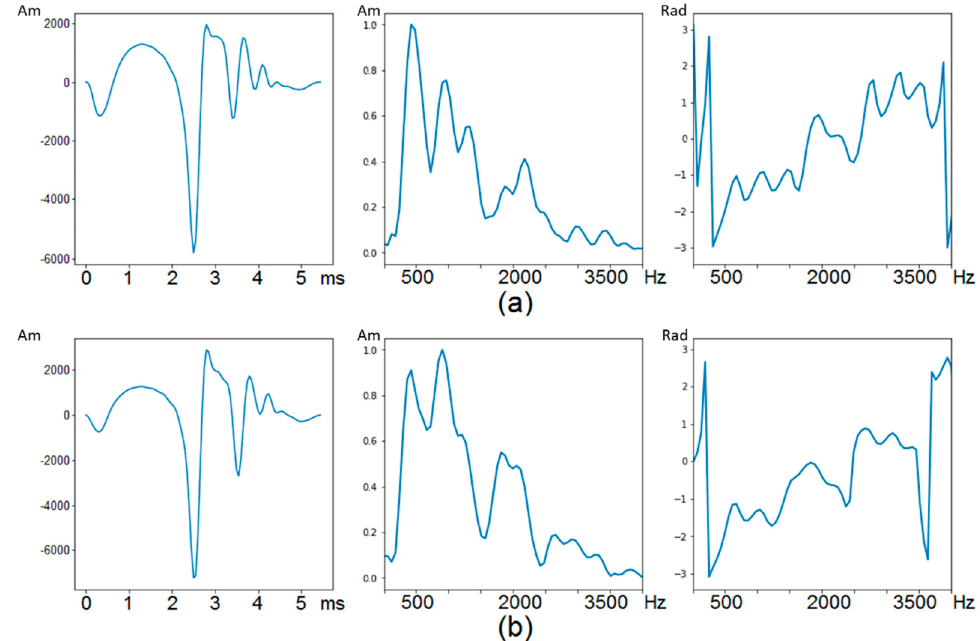
Figure 2. From left to right: The signal form of the direct wave, amplitude spectrum values, phase spectrum values. ( a ) Middle of the profile (signal from the left red frame at Figure 1a), ( b ) near the region of interference with reflections from bottom sediments (signal from the right red frame at Figure 1b).